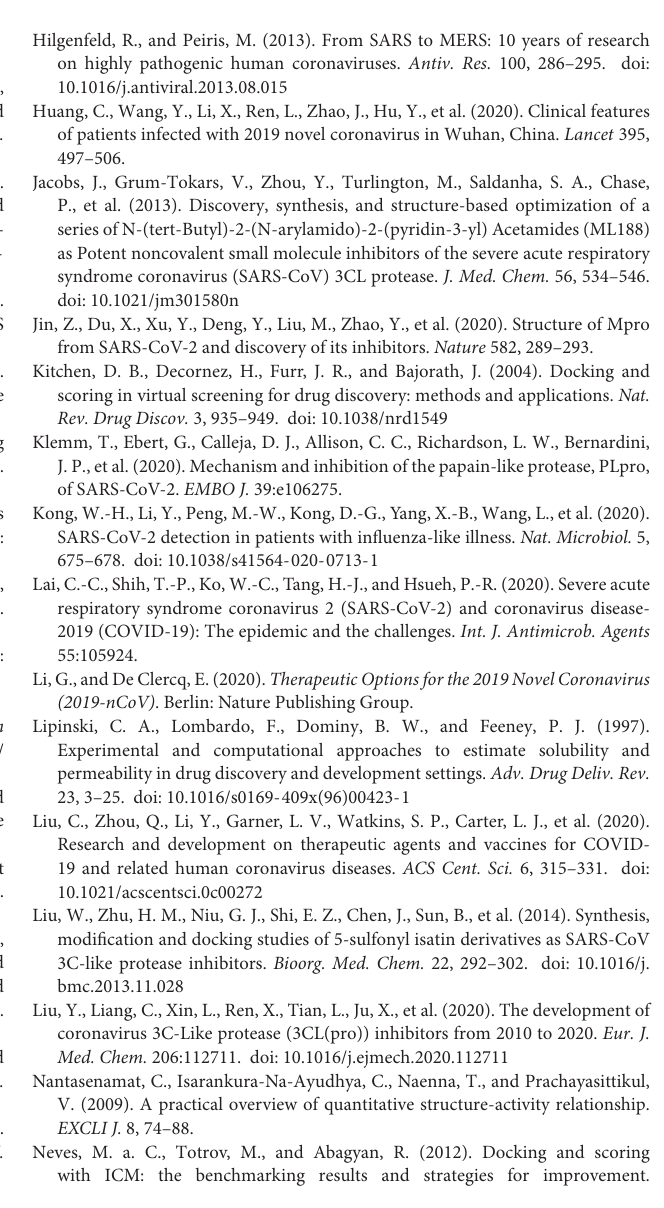
Supplementary Table 1 | Enzyme activity and IC 50 data of PMPT and CPSQPA. Supplementary Table 2 | Inhibitory activity evaluation of 71 compounds. Supplementary Table 3 | The data for QSAR modeling and Docking